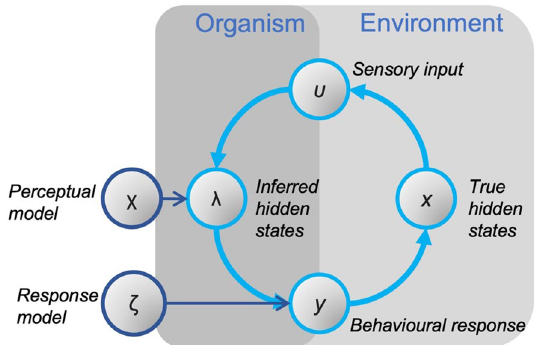
Figure 3. Schematic representation of basic HGF framework. Predictive processing and active inference formulations describe an agent as connected to its environment indirectly by the sensory information it receives ( u ) and the actions it takes ( y ) (i.e., blanket states). An agent must therefore perform Bayesian inference to generate an estimate of the true hidden state of the world ( x ) based on sensory input. In the HGF, the evolution of these estimates over time are described by the perceptual model ( χ ). The responses the agent makes depends on beliefs encoded in the perceptual model, and the relationship between beliefs and behavioural responses are described by the response model ( ζ